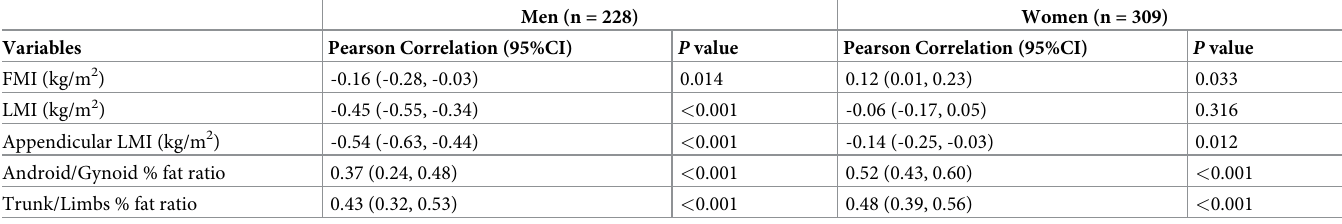
Table 7. List of reference values generated and correlation with age (years) in men and women